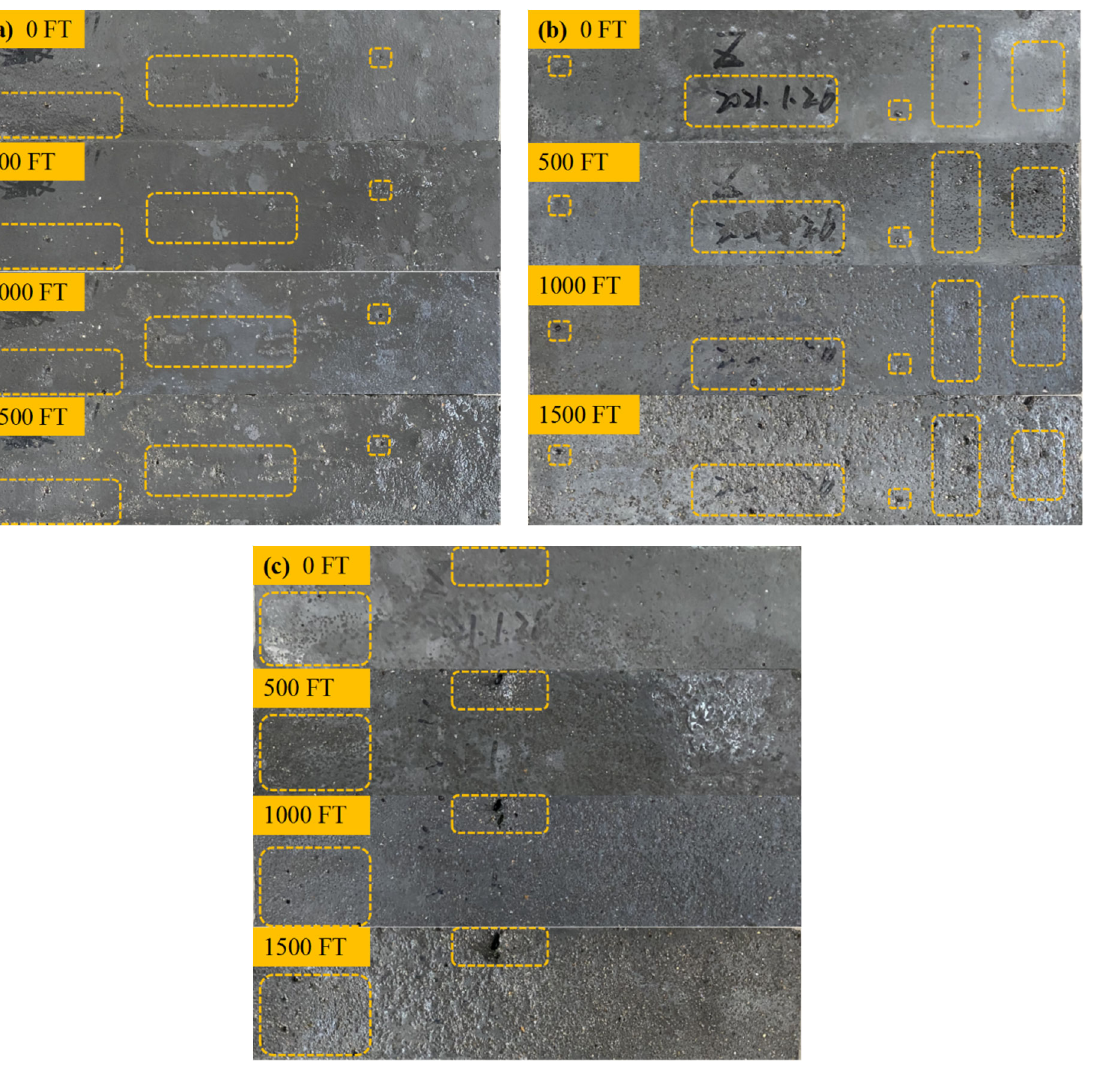
Figure 4. Specimen morphology of MWCNTs UHPC under different salt freezing cycles: ( a ) Bicar-bonate and FT coupling; ( b ) Chloride salt and FT coupling; ( c ) Clean water and FT coupling.